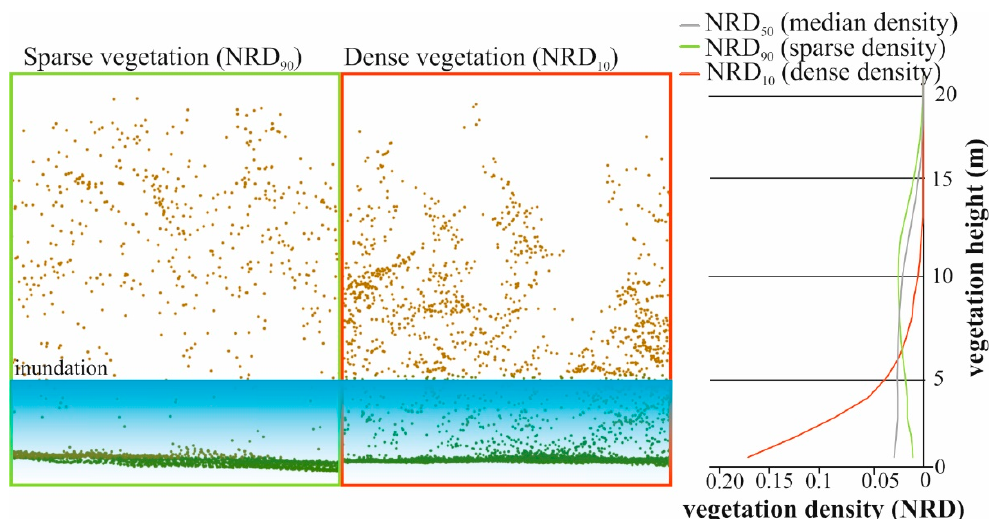
Figure 6. LiDAR point distribution in voxels with sparsely and densely vegetated riparian willow forests, and characteristic vertical distribution of their vegetation density.